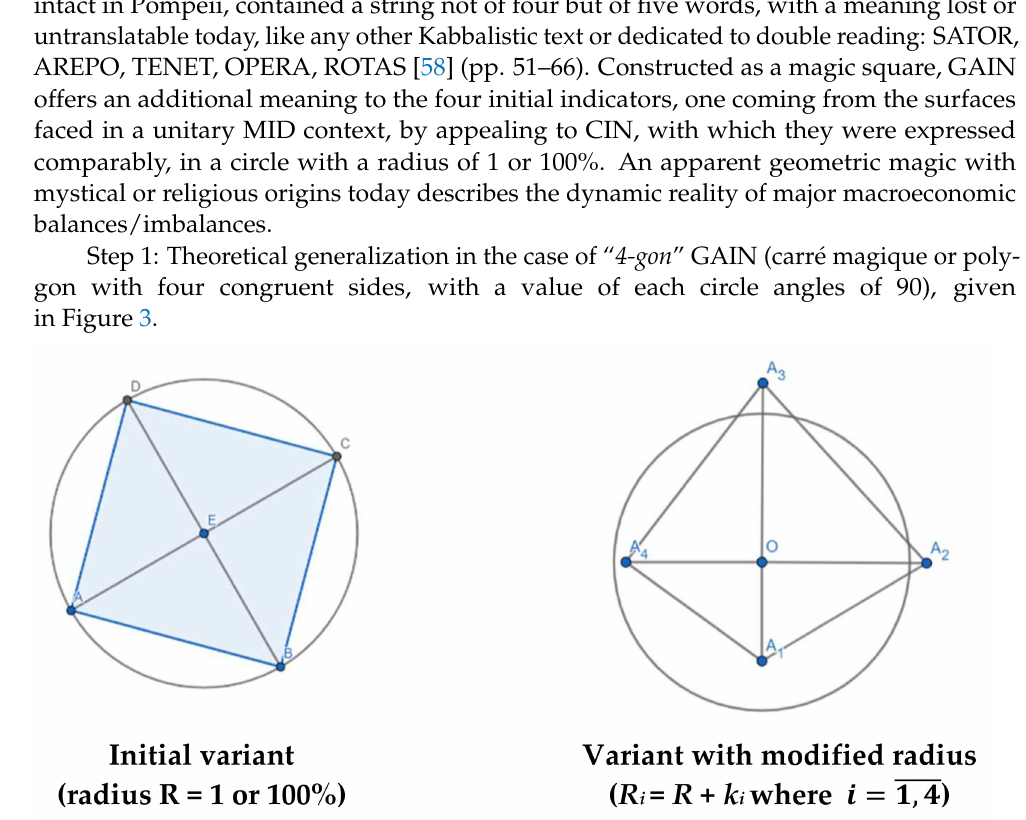
Figure 3. MID-specific dual graphics in “ 4-gon ”